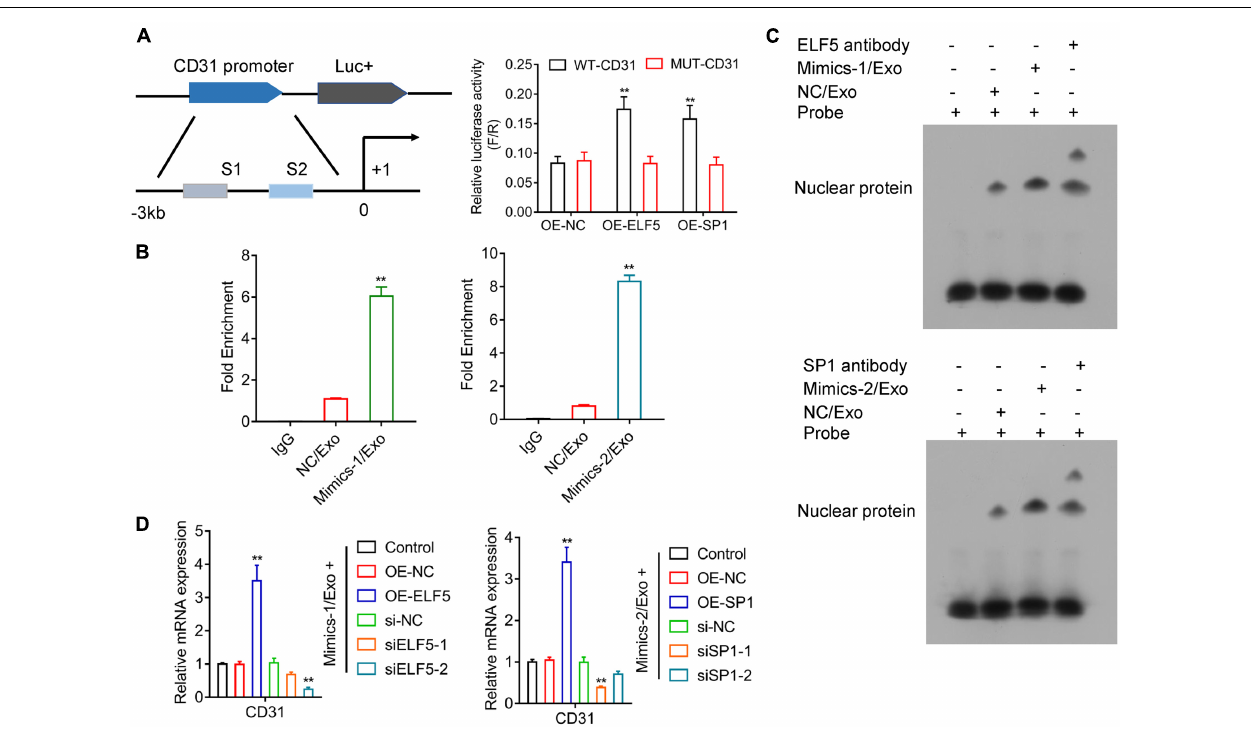
FIGURE 6 | Regulation of CD31 directly by both ELF5 and SP1. Potential binding of ELF5 and SP1 to the promoter of CD31 and induction of the expression were examined by luciferase report assay (A) . In HCF cells treated with control (IgG), NC/Exo, mMimics-1/Exo or Mimics-2/Exo, the association of miR-1246 and miR-1290 with the potential binding of ELF5 and SP1 to the DNA of CD31, respectively, was examined by CHIP (B) and EMSA (C) . In HCFs that received non-transfection or transfection with OE-NC, OE-ELF, or OE-SP1 (si-NC, siELF5-1, siELF5-2, siSP1-1, or siSP1-2), the expression of CD31 was examined by qRT-PCR (D) . N = 3. ** P < 0.01 as compared with the NC group. Exo, exosomes; Mimics-1, miR-1246 mimics; Mimics-2, miR-1290